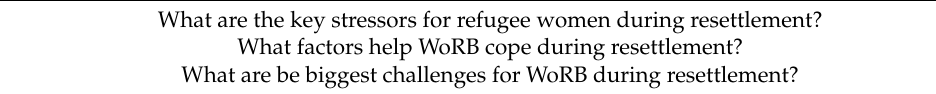
Table 1. Initial Open-Ended Guiding Questions. What are the key stressors for refugee women during resettlement? What factors help WoRB cope during resettlement? What are be biggest challenges for WoRB during